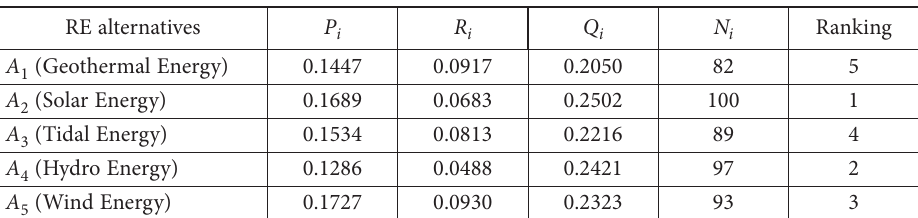
Table 11. The values